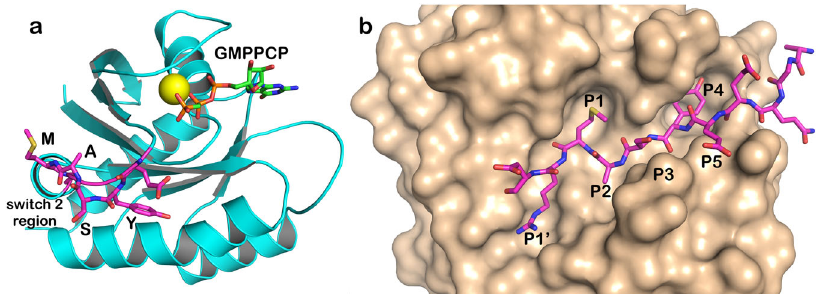
Fig. 1 Target sequence (QEEYSAM) in RAS and in the active site of a RAS-speci fi c protease. a Structure of RAS with a bound GTP analog (PDB code 6Q21) 5,6 , highlighting the YSAM site in Switch 2. b RAS-speci fi c protease based on an X-ray structure of 3BGO.pdb 17 . Cognate sequence QEEYSAM-RD is modeled in the binding cleft. Substrate residues are denoted P1 through P5, numbering from the scissile bond toward the N-terminus of the substrate. The substrate amino acid on the leaving group side is denoted P1 ’